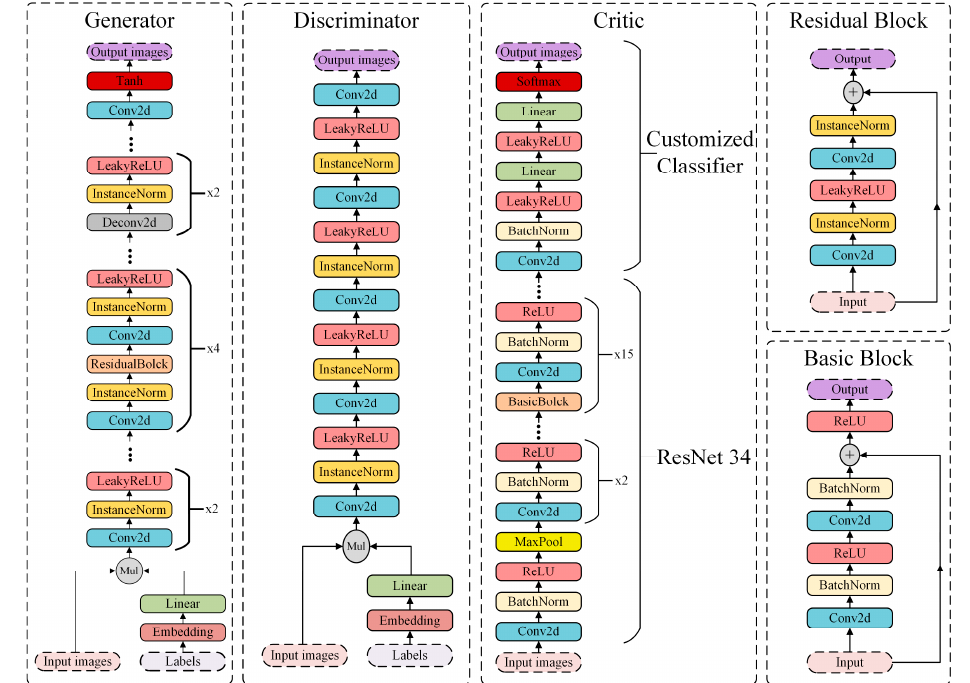
Figure 2. The network architecture of the Generator, Discriminator, and Critic. The residual block is used in the Generator networks, and the basic block appears in ResNet-34. Table 1. The description of each network in the MCC-CycleGAN.